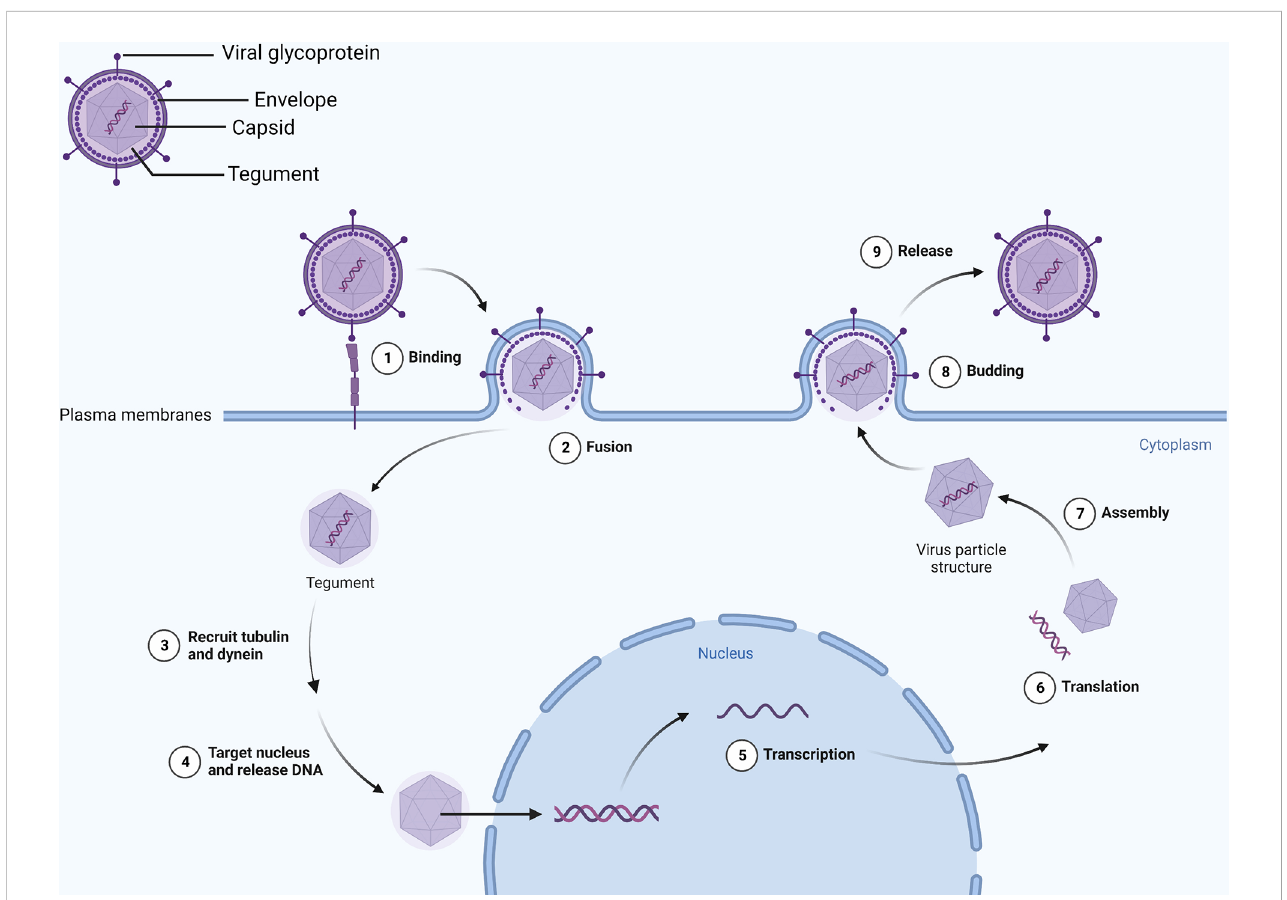
FIGURE 1 Viral envelope glycoproteins mediate binding with the cell membrane. Viral DNA enters the nucleus and transcribes and translates viral particle accessories as the envelope merges with the cell membrane. Eventually, intact virions leave the cell by